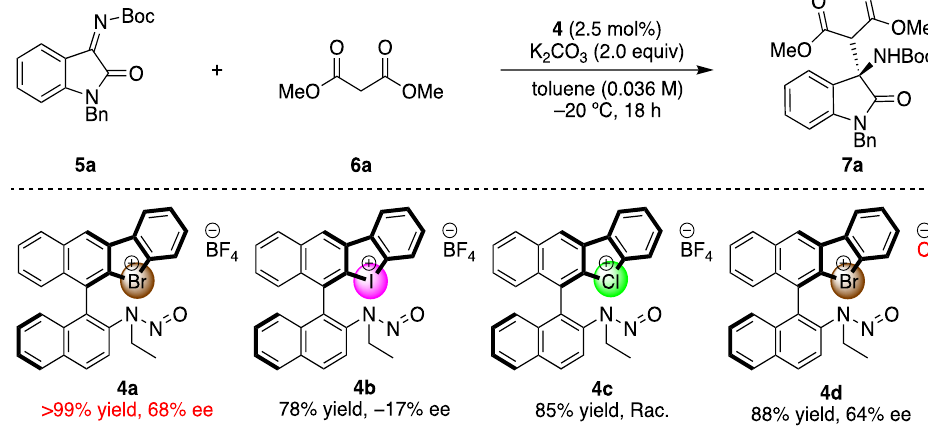
Scheme 2. Screening of the chiral halonium salt